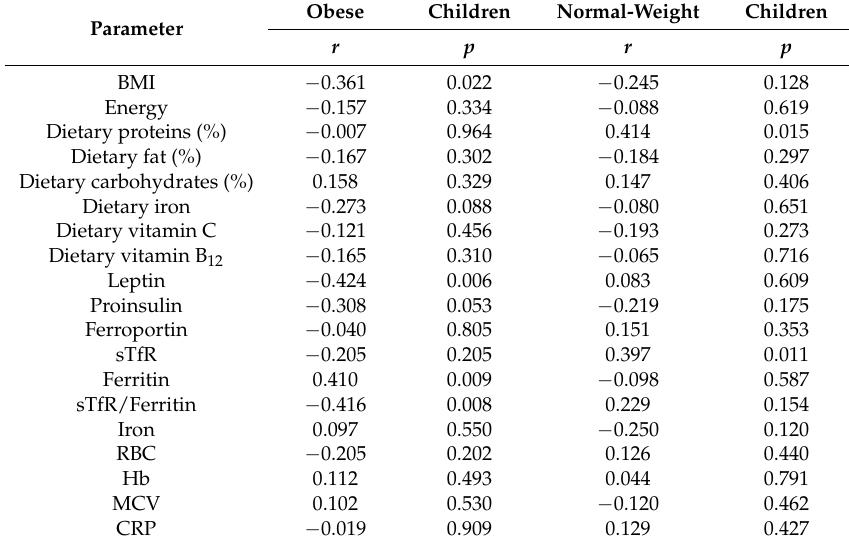
BMI—body mass index, sTfR—soluble transferrin receptor, RBC—red blood cells, Hb—hemoglobin, MCV—mean corpuscular volume, RBC—red blood cells, Hb—hemoglobin, MCV—mean corpuscular volume, CRP—C-reactive protein.